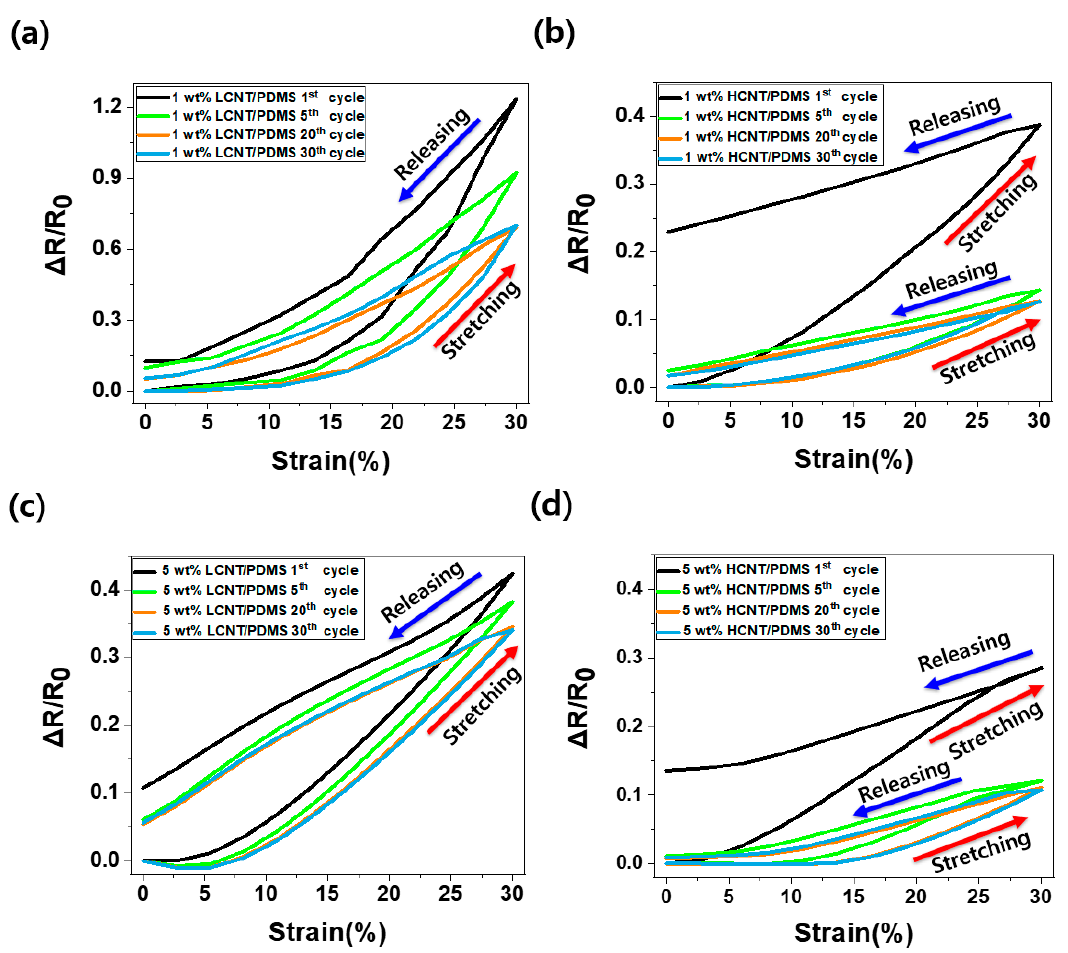
Figure 6. Normalized change in resistance ( ∆ R / R 0 ) versus strain for MWCNTs / PDMS composite under discontinuous cyclic tensile deformation: ( a ) The case of 1 wt% LCNT / PDMS composite, ( b ) the case of 1 wt% HCNT / PDMS composite, ( c ) the case of 5 wt% LCNT / PDMS composite, and ( d ) the case of 5 wt% HCNT / PDMS composite.